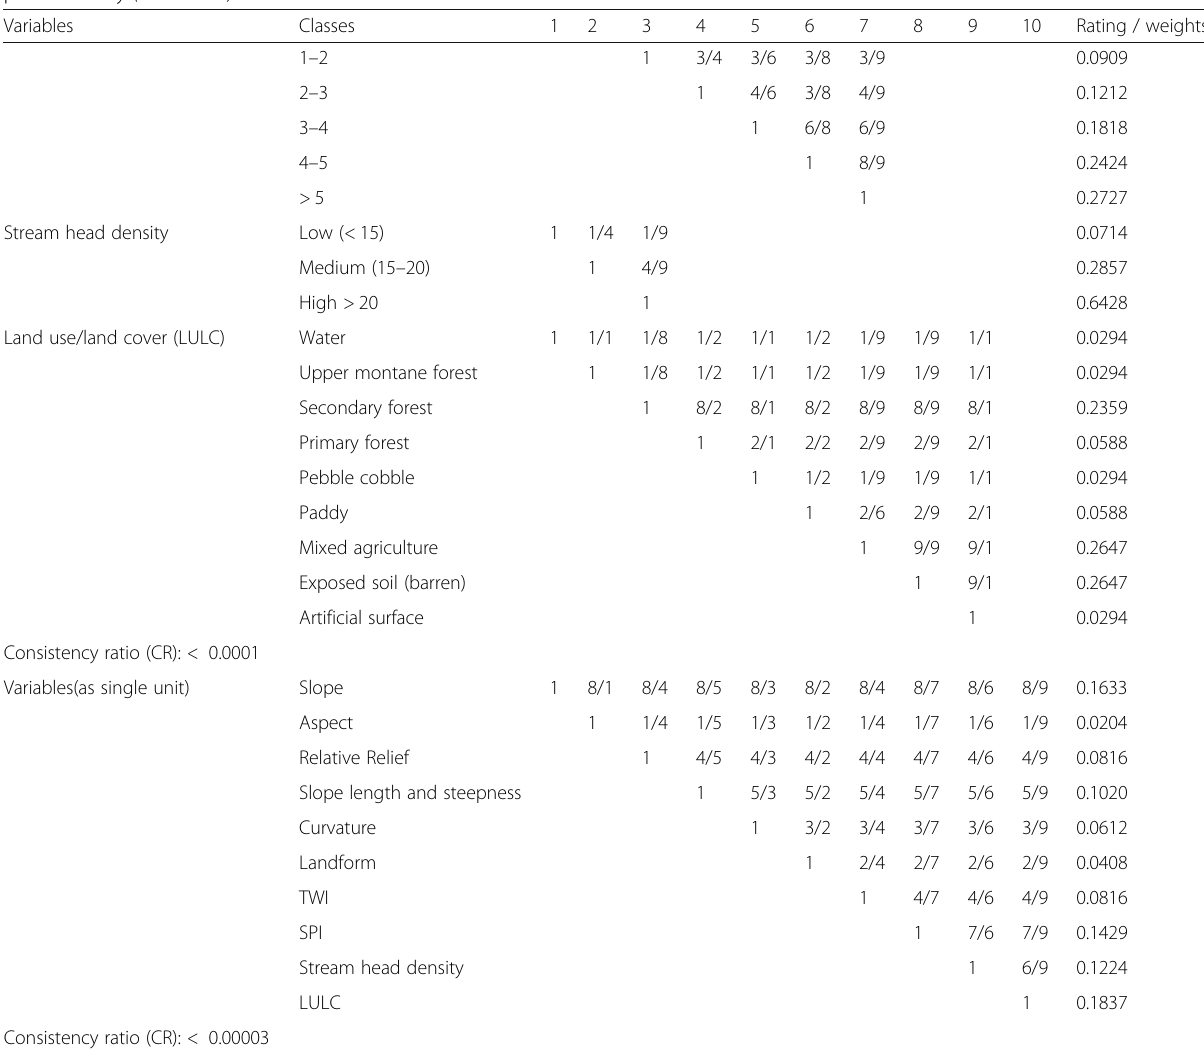
Table 1 Pair-wise comparison matrix, ratings, and consistency ratio of the variables classes and individual variables used in the present study